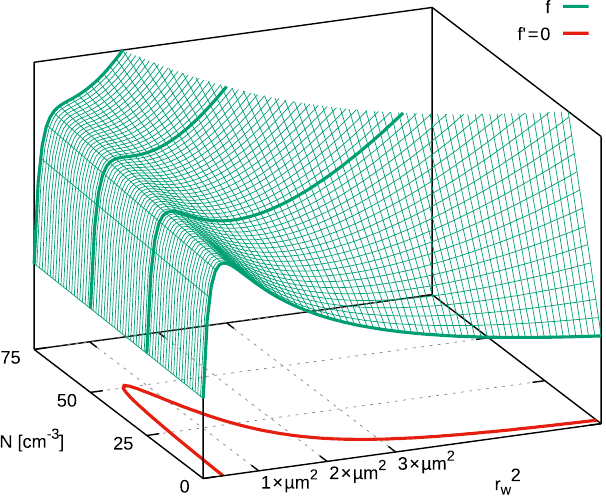
Figure 4. Dependence of f defined in Eq. (11) on the wet radius and particle concentration (green wireframe surface). The red line below depicts the zero-crossings of the first derivative of f with respect to r w . Values of all constants are as in Fig. 3. See Sect.